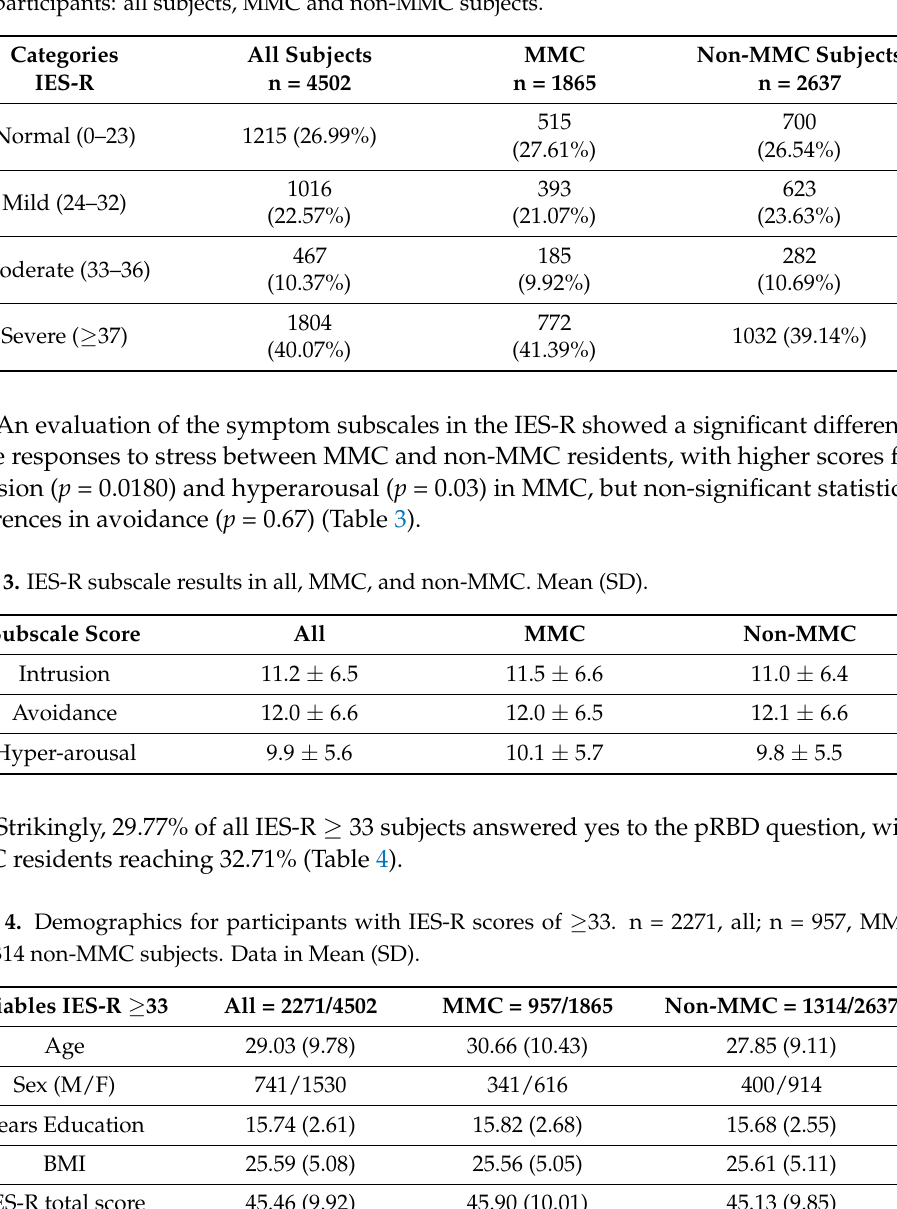
Table 2. IES-R results in the four categories: normal, mild, moderate, and severe psychological stress. 4502 participants: all subjects, MMC and non-MMC subjects.